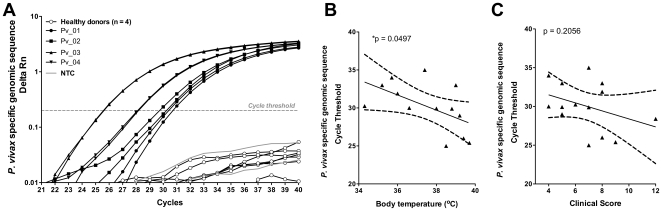

Plasmodium specific genomic sequences circulating in plasma from P. vivax patients.The presence and levels of P. vivax specific plasma CNAs were investigated in samples from P. vivax patients with different clinical presentations by qPCR amplification of a specific P. vivax genomic sequence. (A) For illustration purpose, qPCR amplification of a P. vivax specific genomic sequence in four healthy controls, and four P. vivax patients (Pv_01 to 04) scored according to clinical/hematological parameters is shown. (B) Pearson correlation between the Ct of parasite specific genomic sequence and the body temperature measured at the time of blood collection (r = −0.5535, p = 0.0497) or the clinical score of the patients (r = −0.3604, p = 0.2056). A p value<0.05 was considered significant.